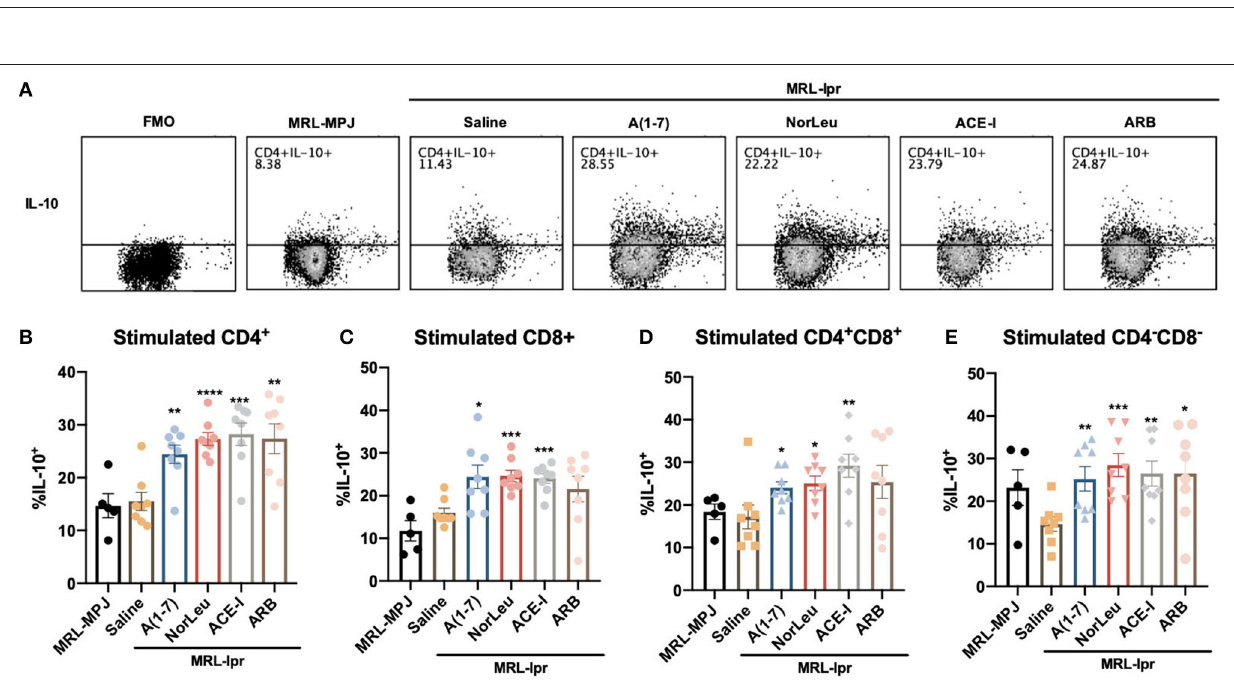
Frontiers in Immunology | www.frontiersin.org